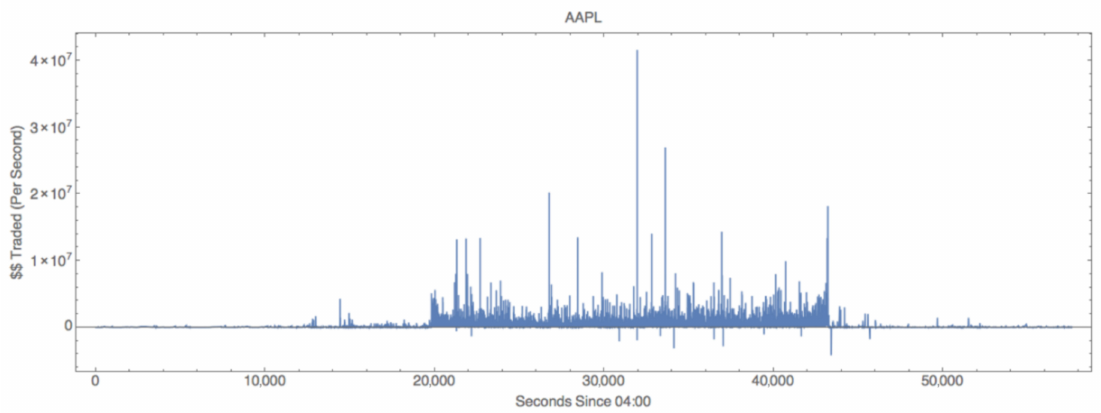
Figure 6. Dollars traded in Apple on 11 August 2015 at each second of the day from 04:00 until